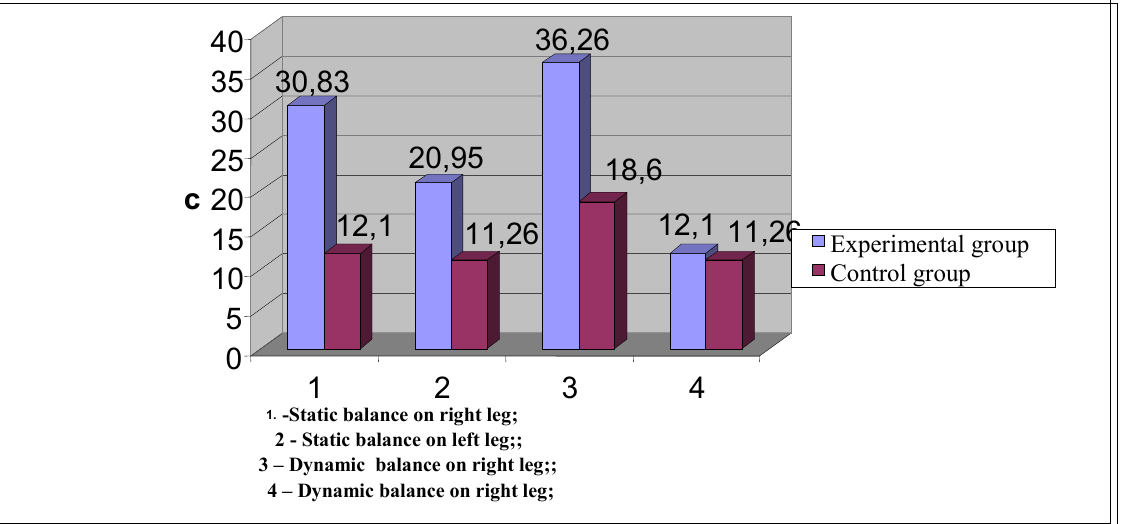
Fig.2. Indicators of static and dynamic